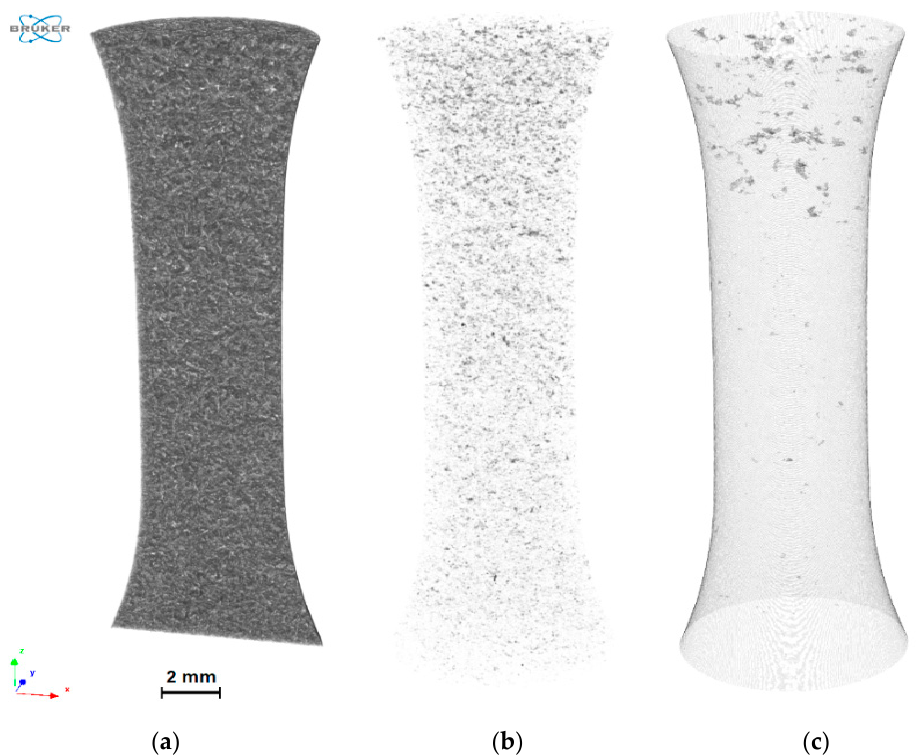
Figure 2. The µ-CT images of microstructure ( a ), second phases ( b ) and pores and shrinkage cavities ( c ) in the gauge length of a sample before loading.